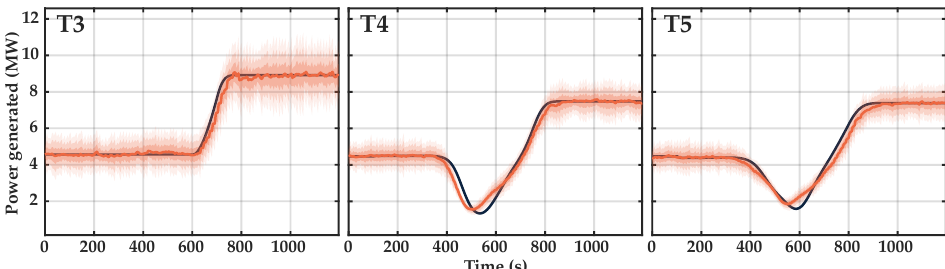
Figure 5. FLORIDyn as reference: the black line shows the FLORIDyn simulation, the orange line shows the estimate with 1,2 and 3 standard deviations.